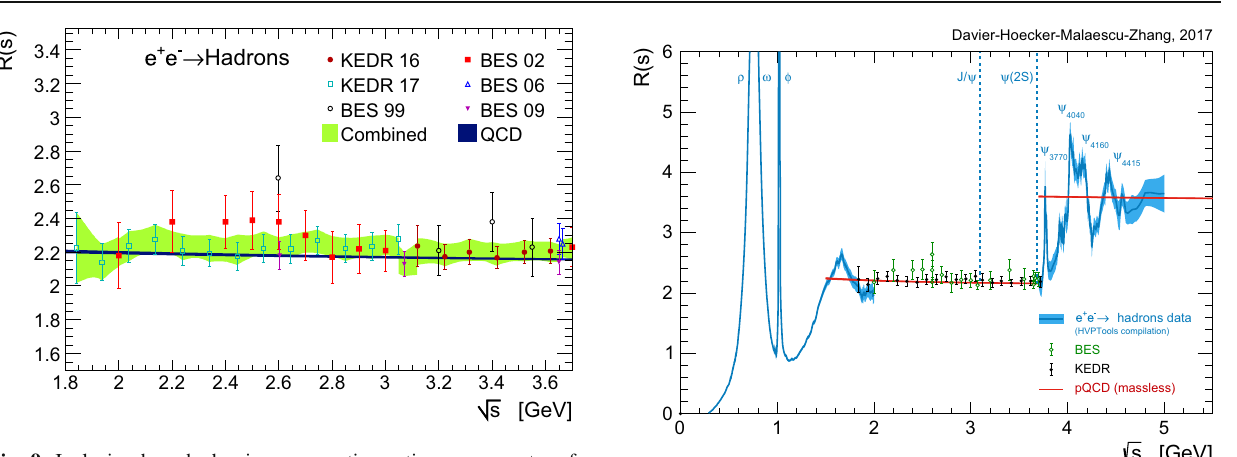
Fig. 9 Inclusive bare hadronic cross-section ratio versus centre-of- mass energy in the continuum region below the DD threshold. Shown are BES [46–49] and KEDR [50,51] data points with statistical and sys- tematic errors added in quadrature, the HVPTools combination ( green band ), and the prediction from perturbative QCD ( dark blue line ) the former quantity we find 7 . 71 ± 0 . 32 and 8 . 30 ± 0 . 09